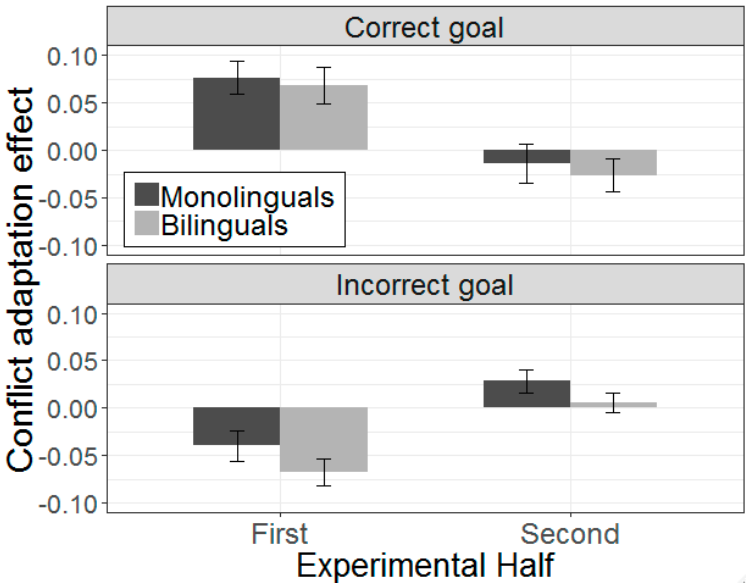
Figure 6. Effect of conflict adaptation on the correct (top) and incorrect (bottom) goal in monolinguals and bilinguals, split by the first and second half of the experiment. Greater values (i.e., more positive for the correct goal, and more negative for the incorrect goal) on the y -axis reflect greater difference between incongruent-ambiguous and congruent-ambiguous sequences and, therefore, greater facilitation from incongruent Stroop sequences. Error bars indicate standard error of the mean.